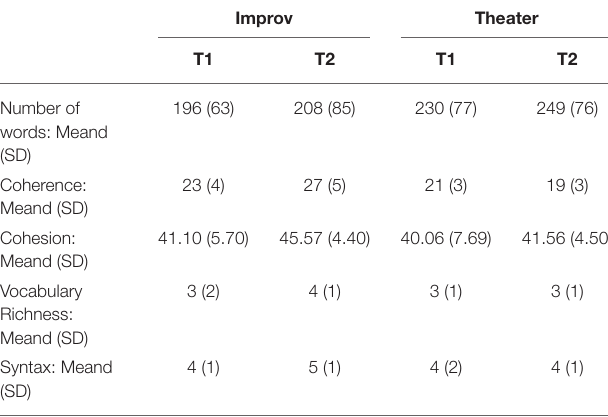
TABLE 2 | Means and standard deviation for each condition and